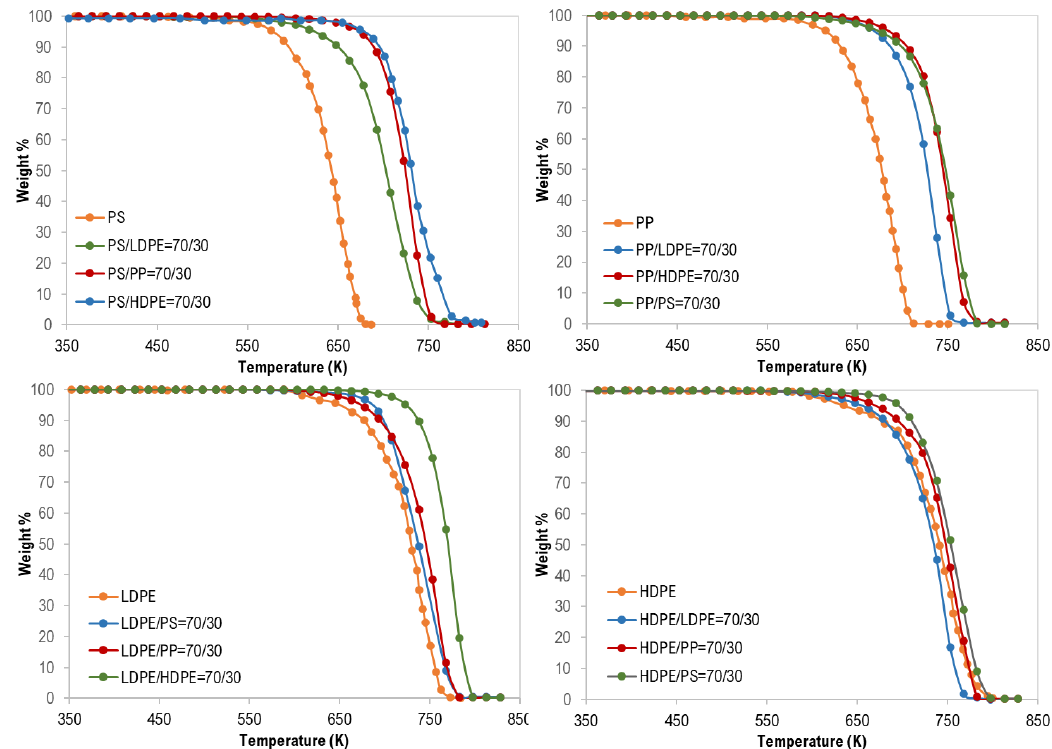
Figure 2. Thermogravimetric (TG) curves of binary mixture polymer waste.